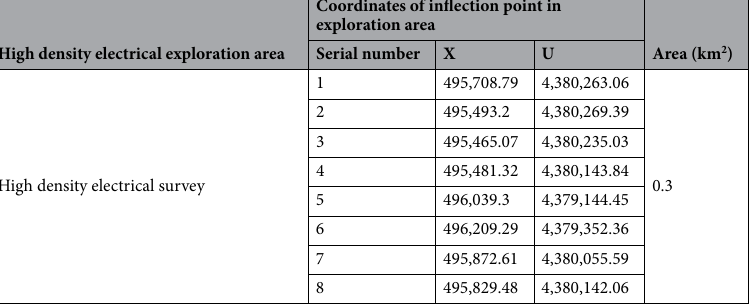
High density electrical exploration